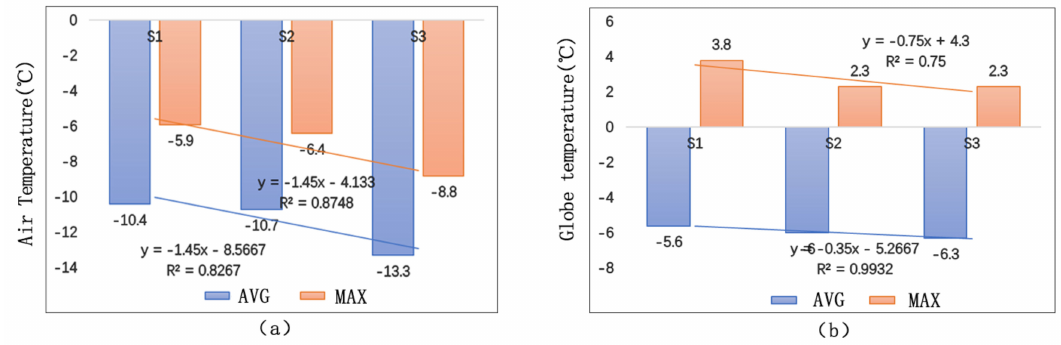
Figure 19. Temperature matching at di ff erent measuring points: ( a ) Ta Matching; ( b ) Tg Matching.